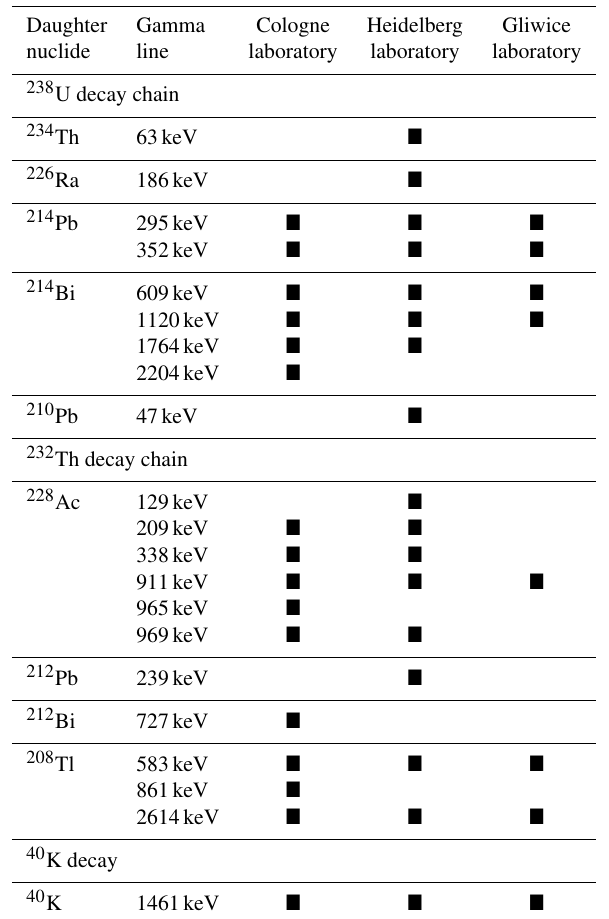
Table A1. Compilation of radioactive daughter nuclides and their associated gamma peaks used for low-level HRGS-based uranium, thorium and potassium determination in the participating laborato- ries of Cologne, Heidelberg and